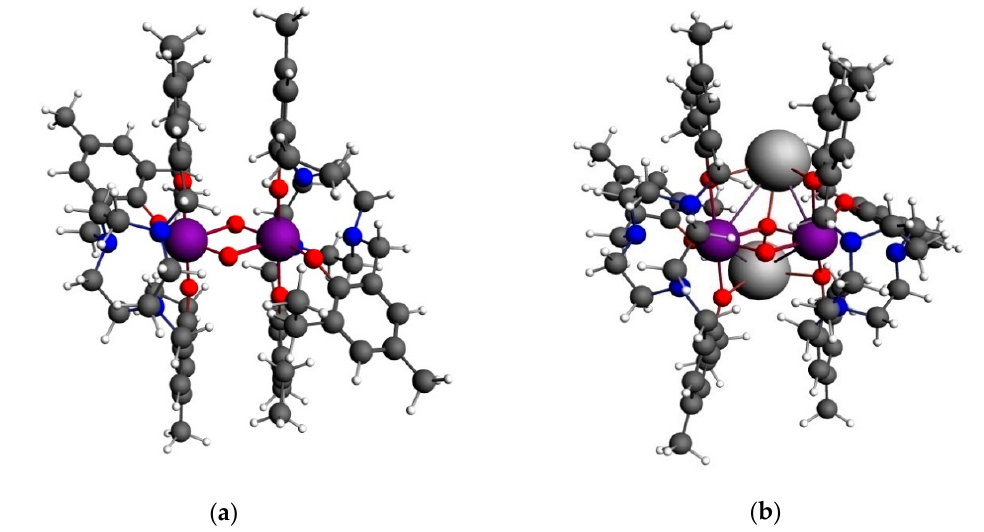
Figure 19. Optimized molecular structures of the ( a ) [U V (µ-O) 2 U V ] and ( b ) K 2 [U IV (µ-O) 2 U IV ] complexes (reprinted with permission from [155], American Chemical Society, 2016).